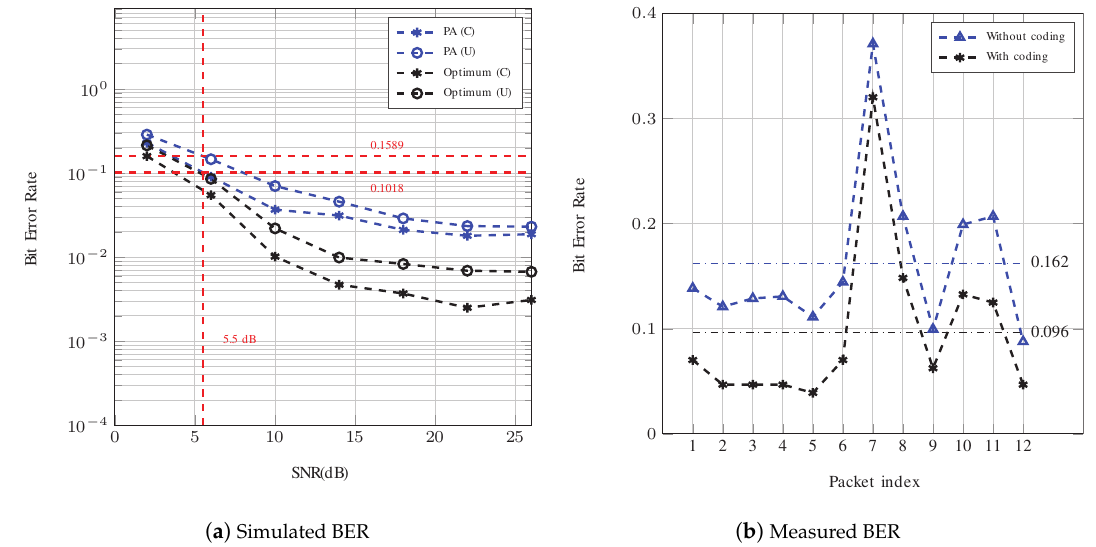
Figure 9. BER analysis of Config. #1. The red dotted lines in ( a ) show the value of BER at 5.5 dB for system with PA compensation (with and without coding). The horizontal lines in ( b ) are used to identify the average measured